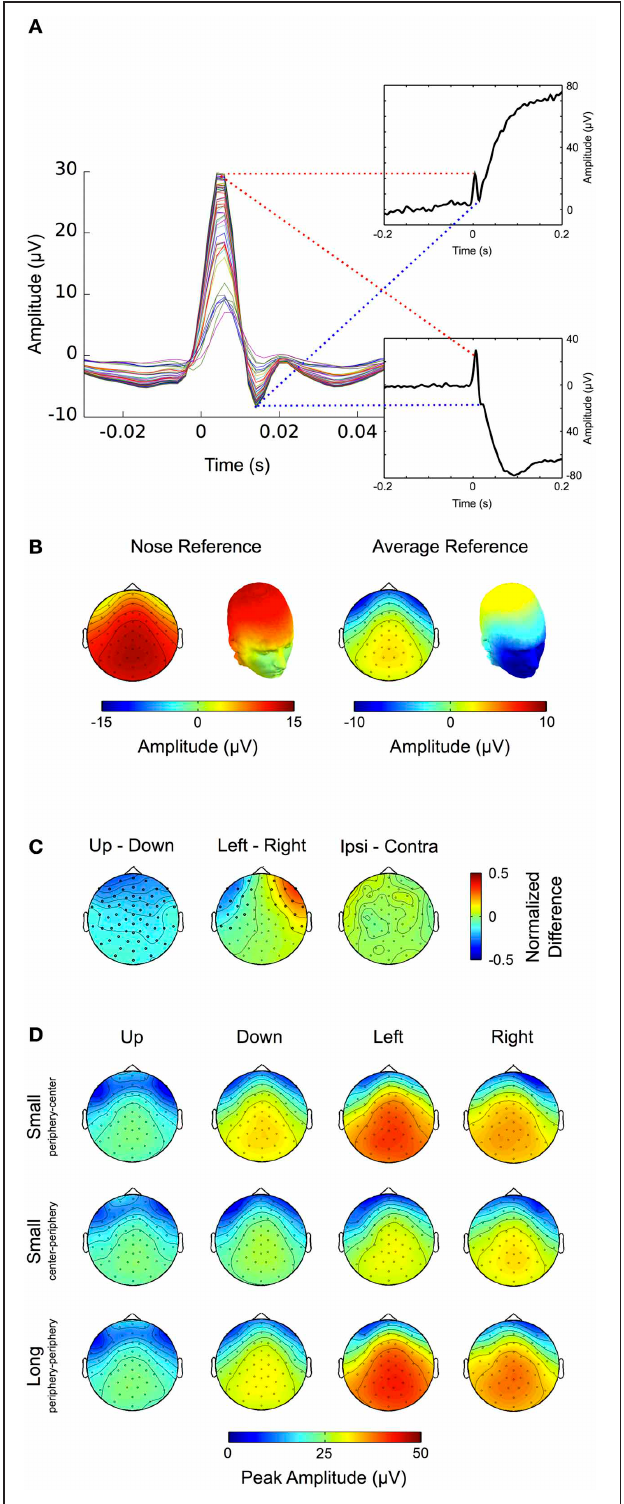
FIGURE 6 | Saccadic spike potential. (A) After removal of the corneo-retinal dipole by high pass filtering the data at 30Hz, the spike potential displays a biphasic shape at all scalp electrodes (colored traces).